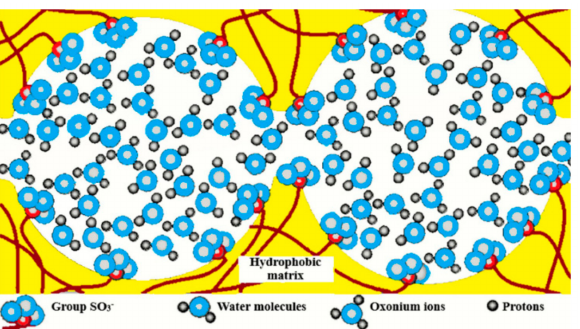
Figure 1. Schematic representation of Gierke model. Reprinted with permission from [87]. Copyright 2013 Springer